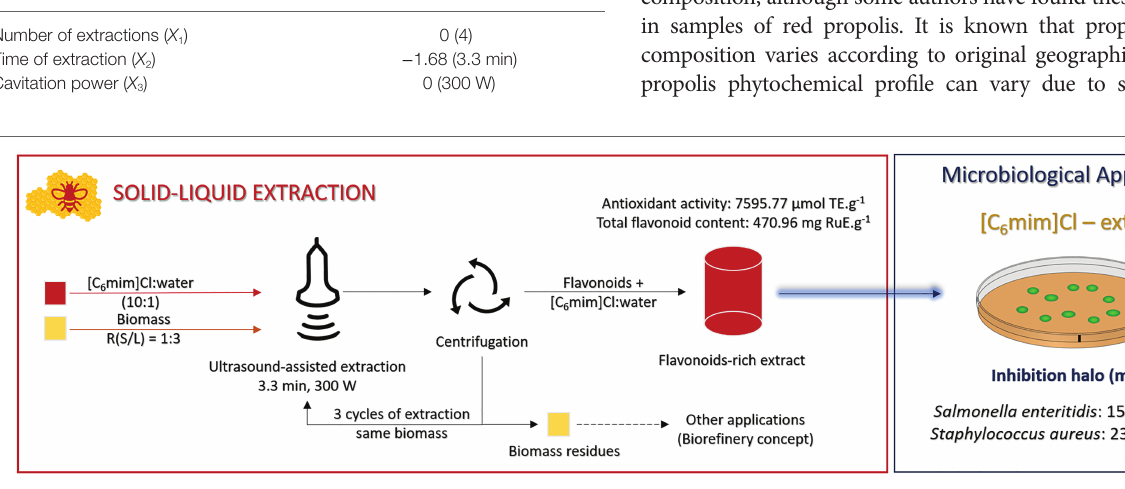
TABLE 3 | Extraction condition for the antioxidant activity model validation. Independent variables Levels